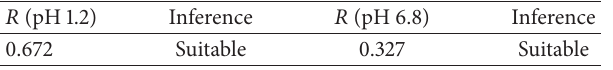
Table 5: Calculation of suitability of adsorbent to adsorbate/con-